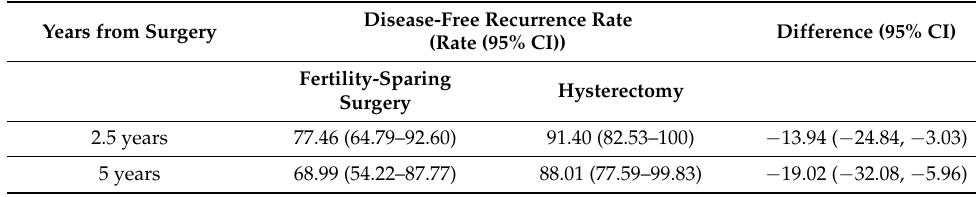
Table 6. Differences in disease-free survival rates at 2.5 and 5 years after